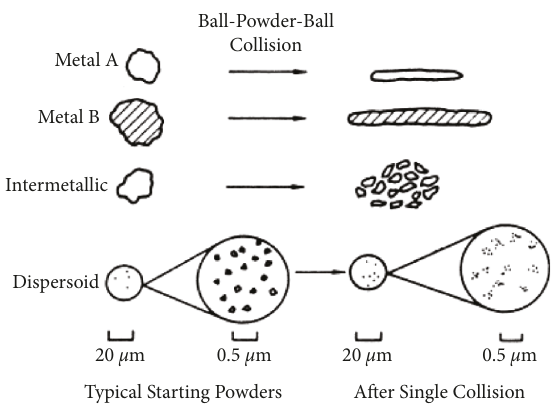
Figure 2: Mechanism of mechanical alloying